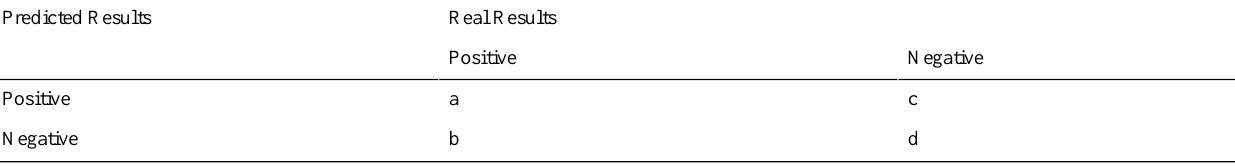
Table 3. Confusion